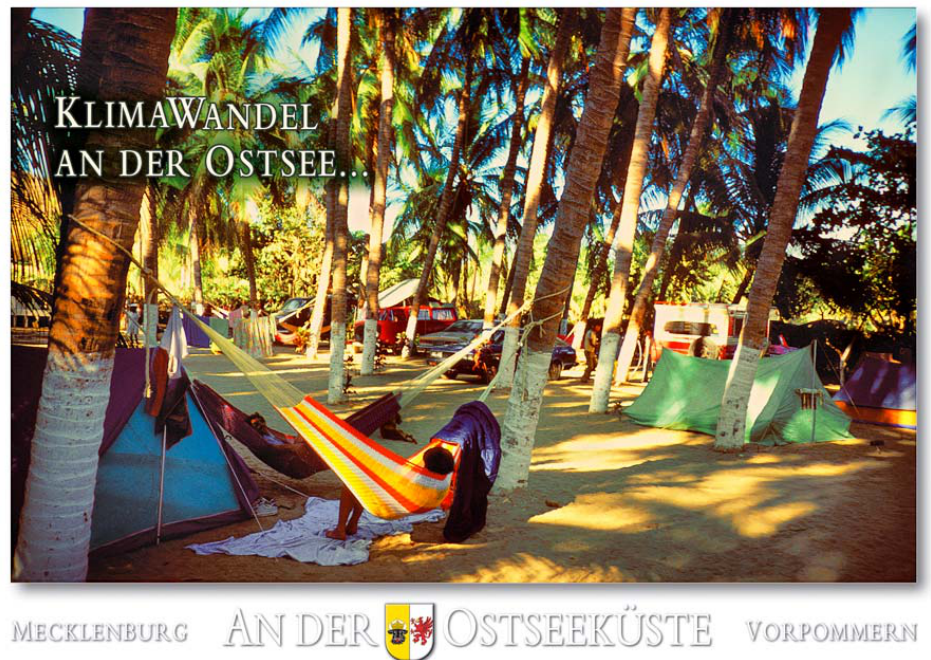
Source: Ekkeheart Gurlitt (Foto & Design),